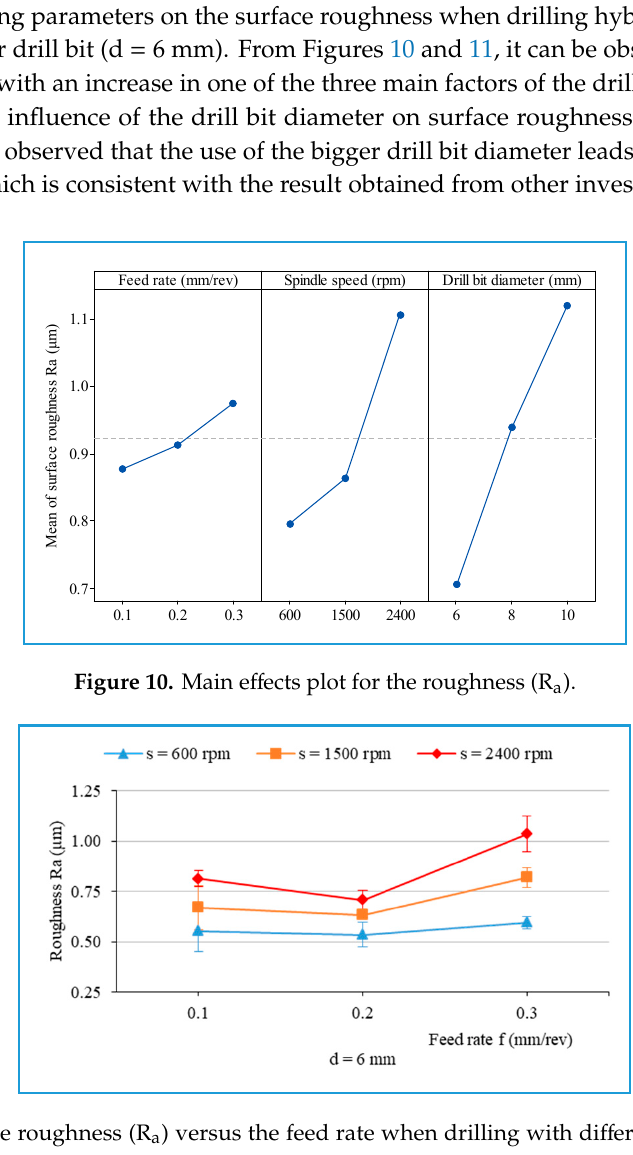
Figure 12. The roughness (R a ) versus drill’s diameter with different feed rates and spindle speeds: ( a ) s = 600 rpm, ( b ) s = 2400 rpm.